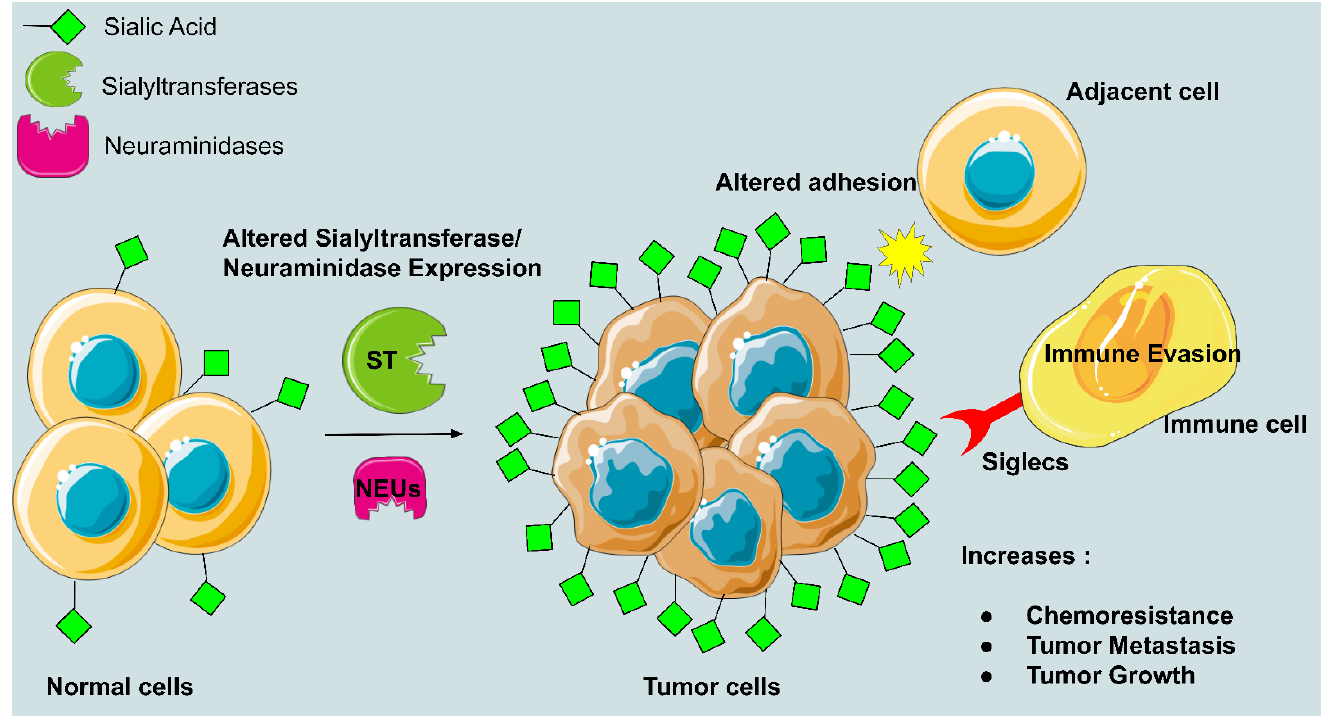
Figure 2. Hypersialylation in tumor cells and its adverse effects. The figure demonstrates aberrant sialylation by upregulation of sialyltransferases or downregulation of neuraminidases, or both con- tribute to the accumulation of excess negative charge in cancer cells leading to immune evasion, altered adhesion between adjacent cells, etc. altered adhesion between adjacent cells,